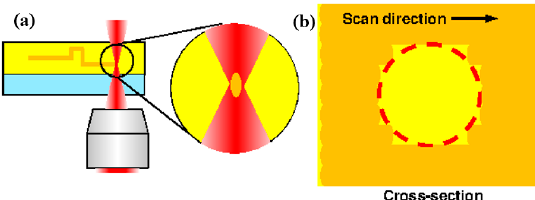
Figure 3. Cause of a rough surface by femtosecond laser exposure. ( a ) Femtosecond laser scanning process; ( b ) Cross-section of the photoresist after scanning.